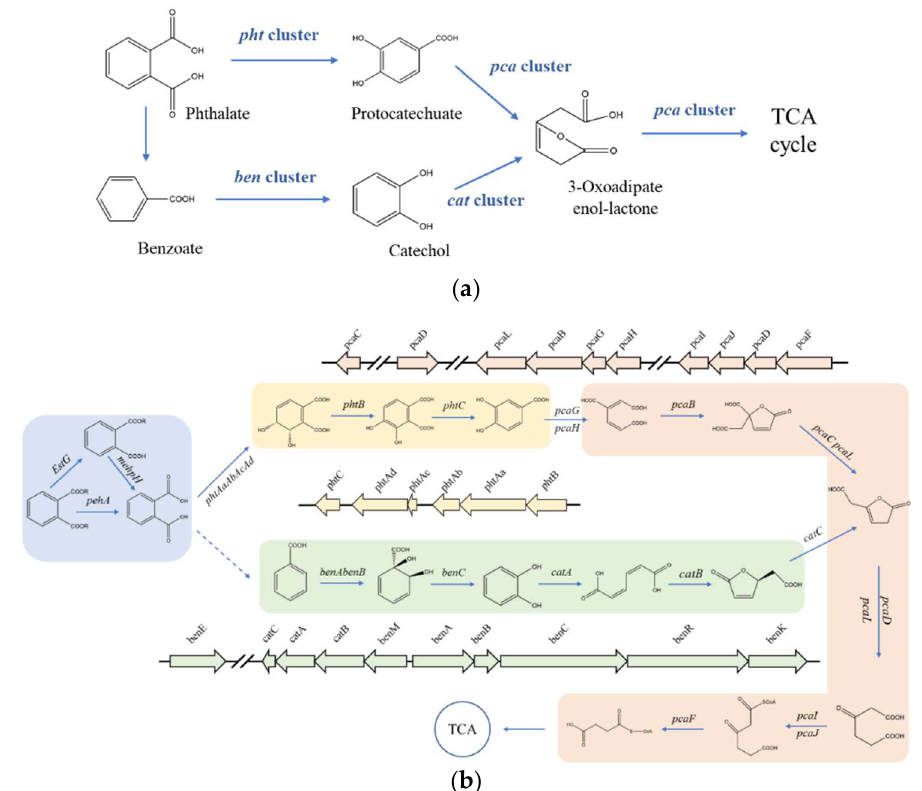
Figure 4. Gene clusters ( a ) the putative pathways ( b ) of PAEs degradation and in Gordonia sp. GZ- YC7. Module 1 in blue is catalyzed by esters; Module 2 in yellow is catalyzed by the pht gene cluster; Module 3 in green is catalyzed by the ben and cat gene clusters; Module 4 in red is catalyzed by the pca gene cluster.